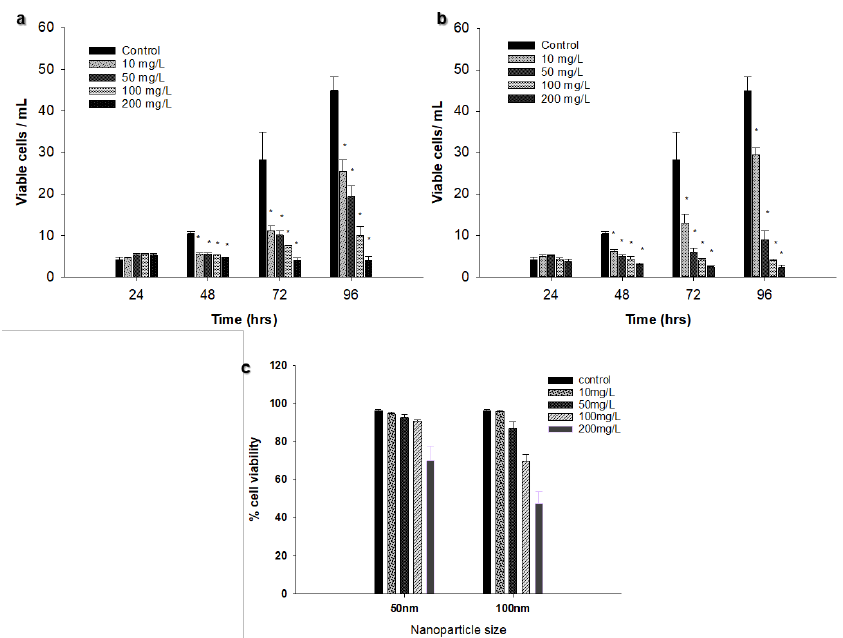
Figure 4. Effect of different concentrations of Ag NPs on viable cell concentration ( a ) 50 nm Ag NPs, ( b ) 100 nm Ag NPs. ( c ) Effect of Ag NPs size and concentration on % of viable Chlorella vulgaris cells at 96